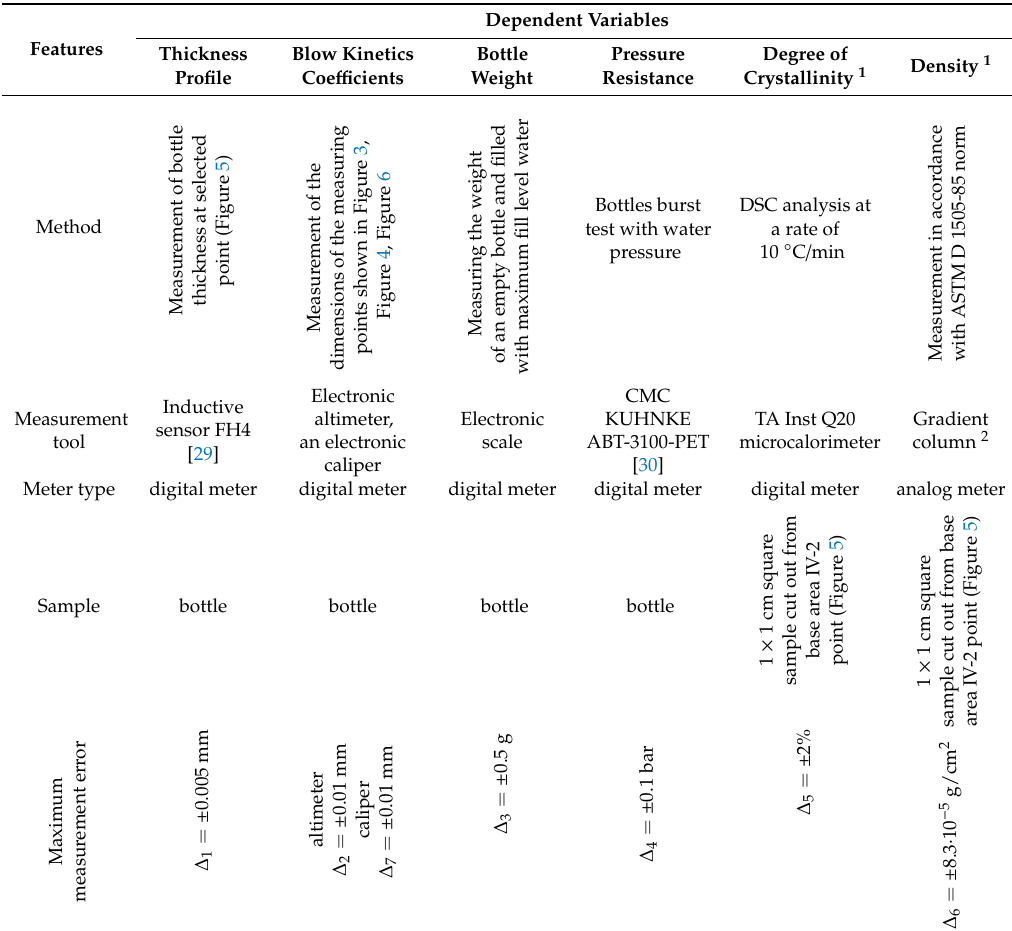
Table 3. A summary of information on methods and measurement tools used for individual dependent variables—for the maximum measurement error a rectangular error distribution was assumed for the entire measurement